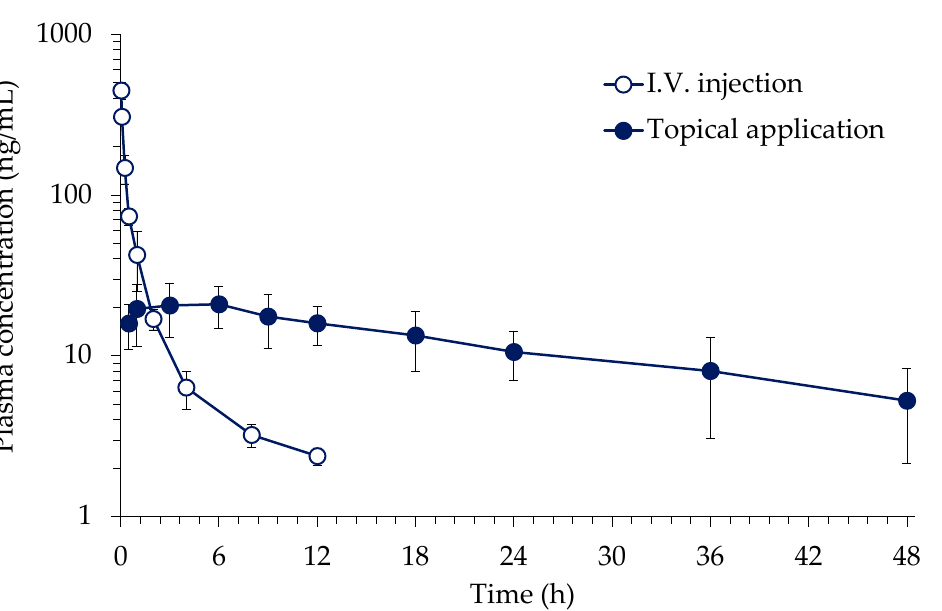
Figure 2. Average plasma concentration-time profiles of BP-3 obtained after i.v. injection and transdermal administration at doses of 1 mg/kg (n = 4) and 40 mg/kg (n = 5), respectively, in rats (mean ± S.D.). Table 3. Toxicokinetic parameters of BP-3 obtained after i.v. injection and transdermal administra- tion at doses of 1 mg/kg and 40 mg/kg, respectively, in rats (mean ± S.D.).